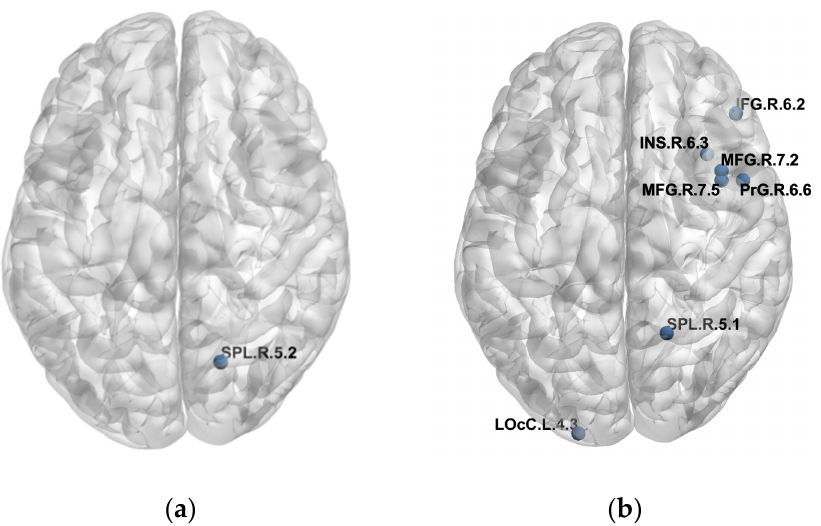
Figure 2. Detailed brain regions with significant correlation of FCs/PLFCS and tau SUVR. ( a ) Brain regions with significant correlation of FCs/PLFCS and tau SUVR in the MCI group. ( b ) Brain regions with significant correlation of FCs/PLFCS and tau SUVR in the AD group.